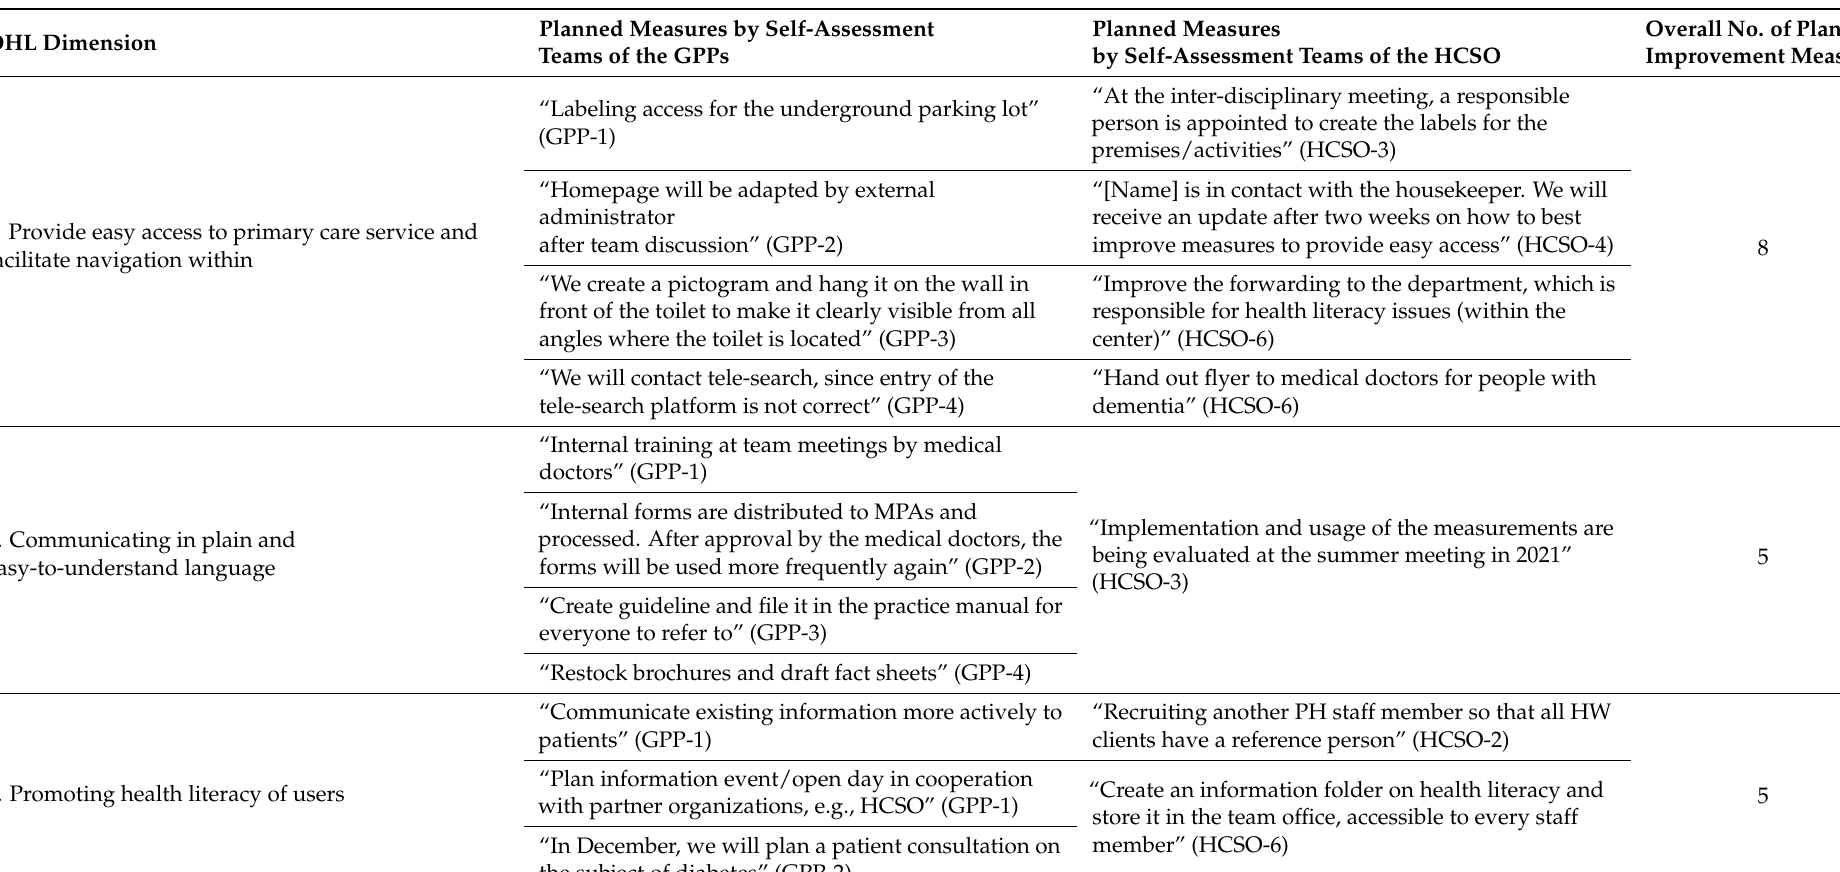
Table 5. Overview on the planned improvement measures per dimension in teams of the GPPs and the